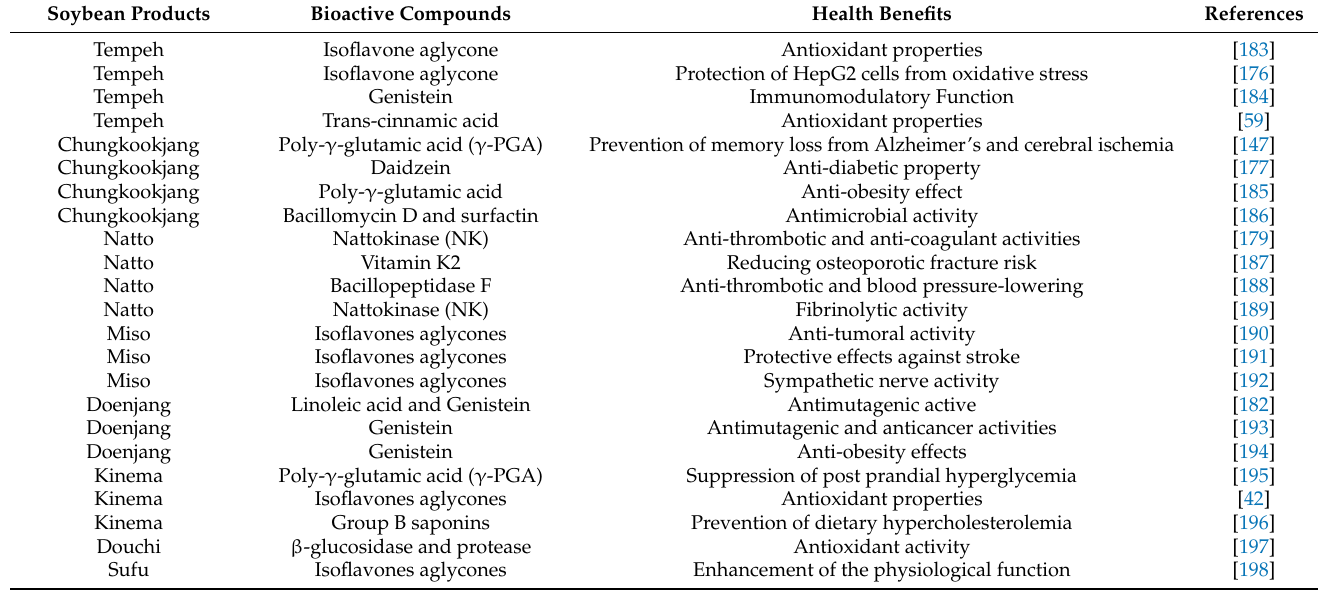
Table 3. Bioactive compounds of different fermented soy products and their health benefits. Soybean